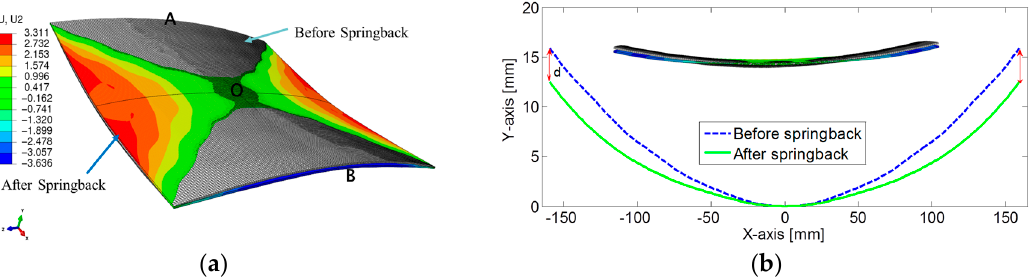
Figure 4. Case of visible springback: ( a ) Nodal displacement distribution; ( b ) Curvature radii at section AB.